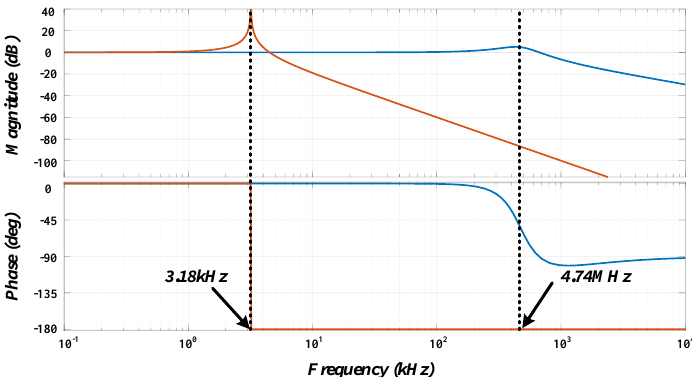
Figure 6. Bode plot of dv / dt filter and sine-wave filter (red line: sine-wave filter, blue line: dv / dt filter).